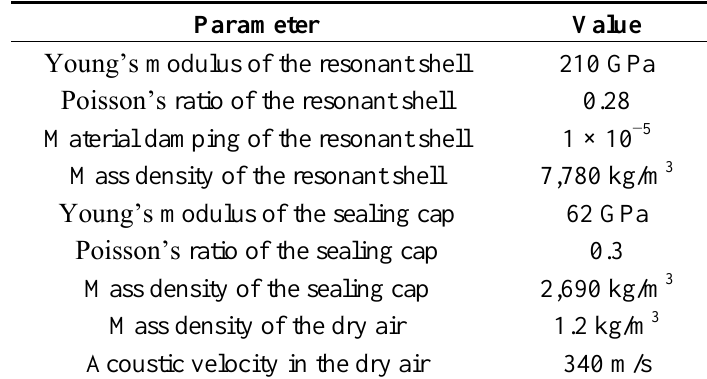
Table 2. Material properties of the gyroscope and the dry air.